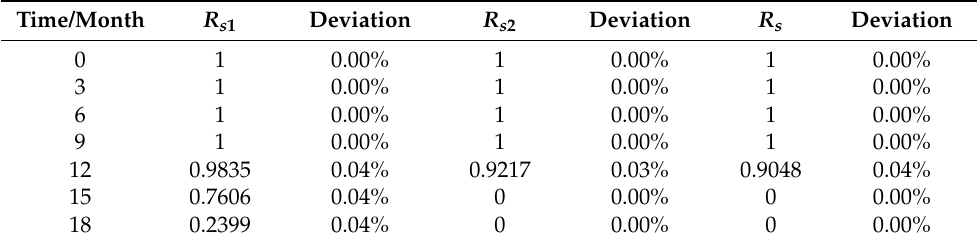
Table 4. Parameters at each time point of the O-ring.